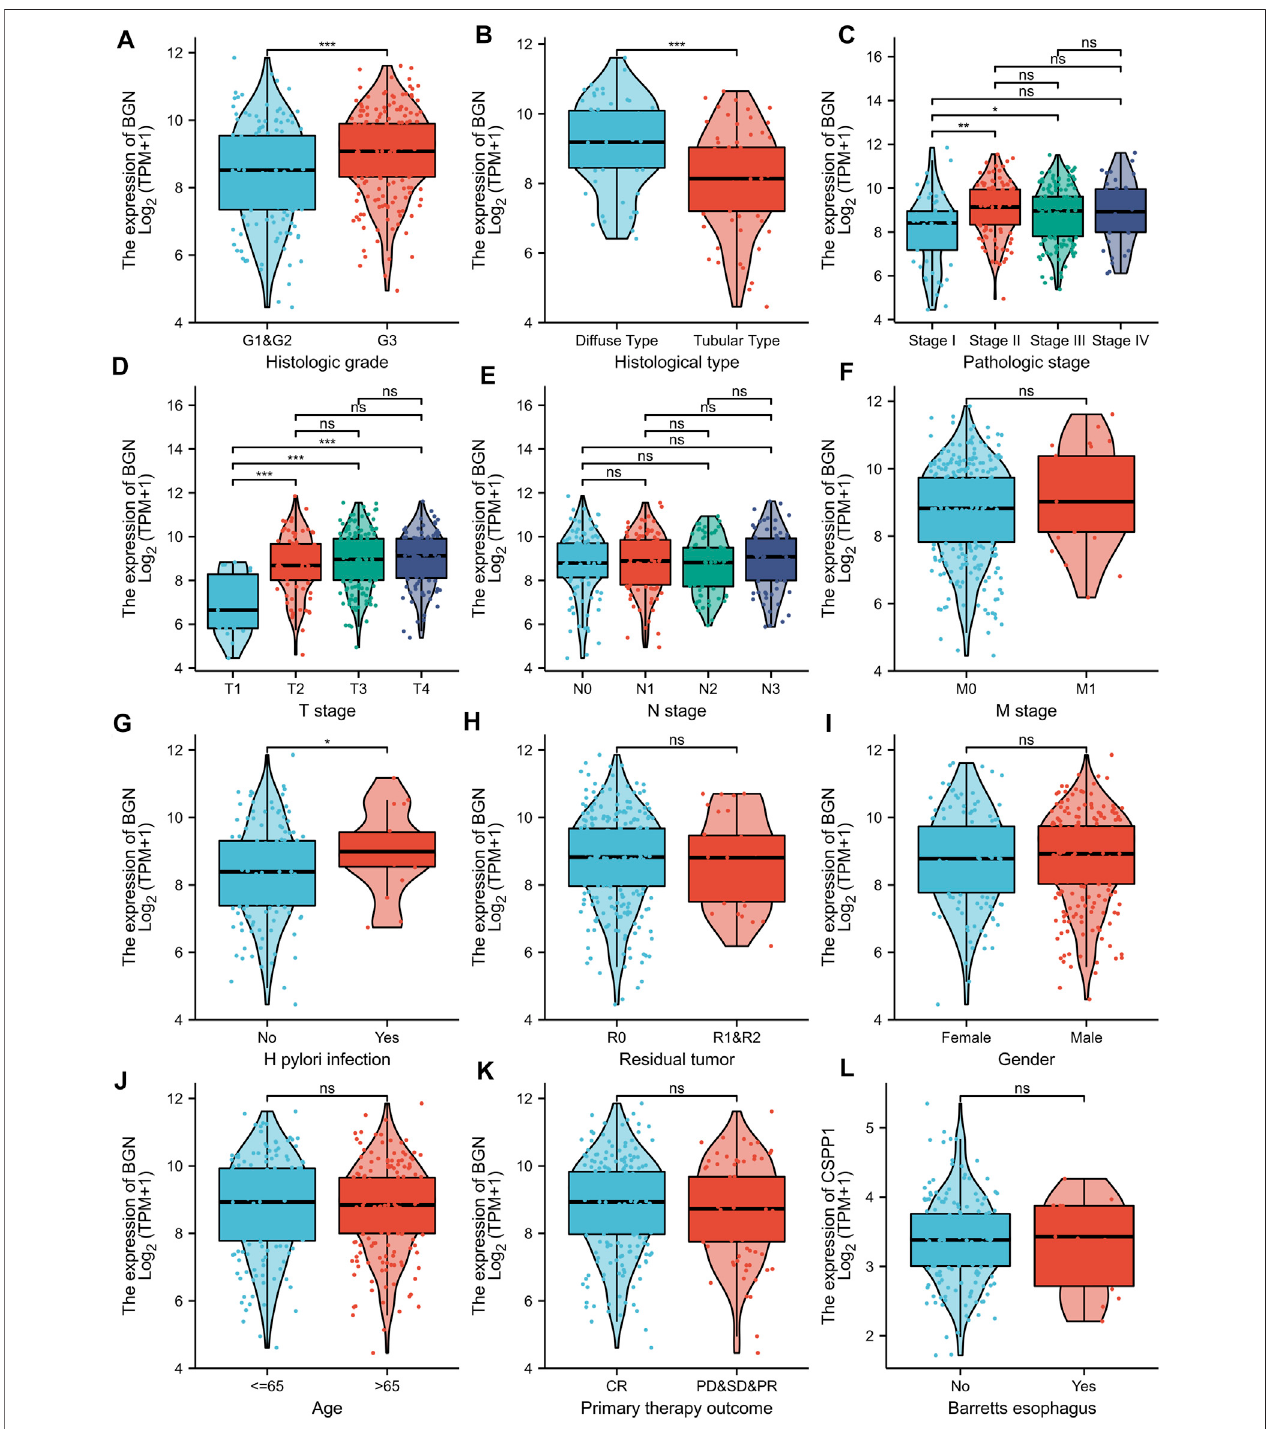
FIGURE 3 | Volcano plot of the DEGs, Functional enrichment analysis and GSEA analysis. (A) : (E) Volcano plots of the DEGs. Blue represent down-regulated DEGs, red represent up-regulated DEGs. (B) : The top three items enriched in biological processes (BP), cellular component (CC), molecular function (MF), and Kyoto Encyclopedia of Genes and Genomes (KEGG) of DEGs. (C – H) : Enrichment plots from the gene set enrichment analysis (GSEA). NES, normalized enrichment score; p.adj, adjusted p-value; FDR, false discovery rate.